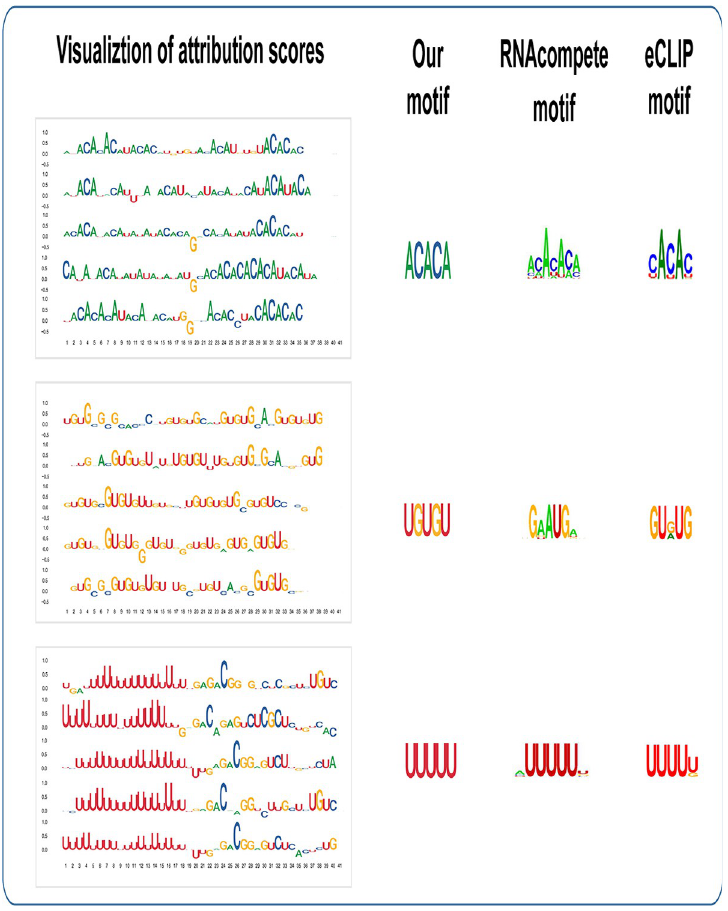
Fig 4. Visualization of attribution scores, consensus motif, motifs obtained from in vitro (RNAcompete) and in vivo (eCLIP) experiments.